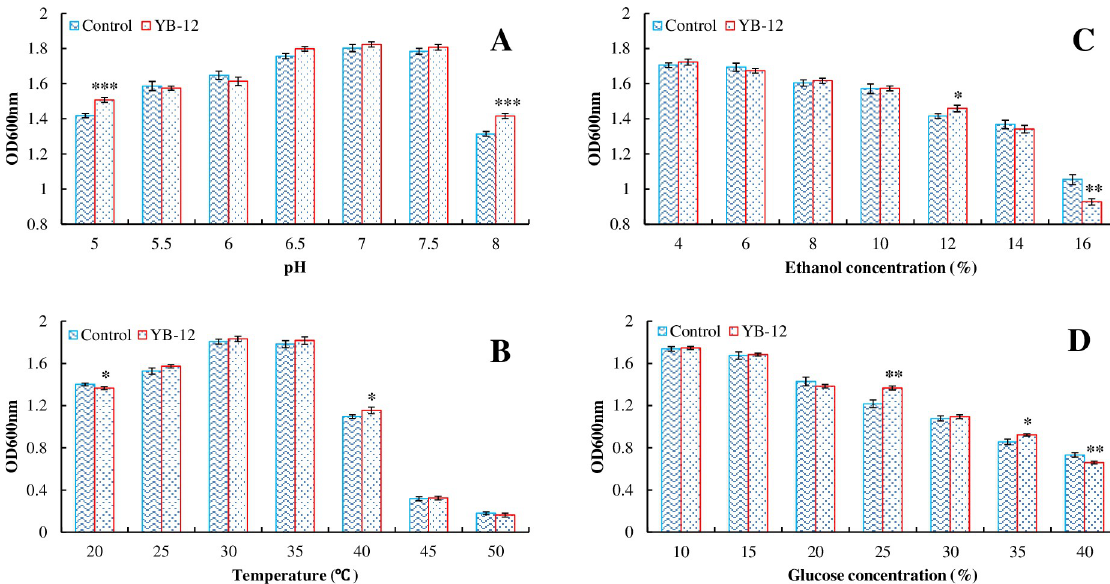
Fig 3. Effects of pH (A), temperature (B), ethanol concentrations (C) and glucose concentrations (D) on the growth of YB-12. Significance levels: � , P = 0.05; �� , P = 0.01; ��� , P = 0.001.